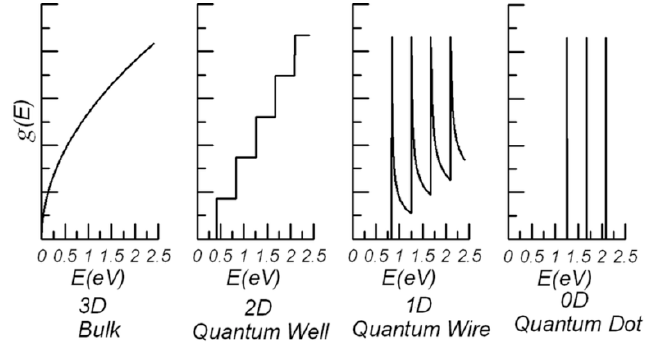
Figure 2. General behavior of the DOS function in the systems of different dimensionality. Reproduced with permission from Ref. [68]. Copyright 2005, Acta Physica Polonica A : Institute of Physics,